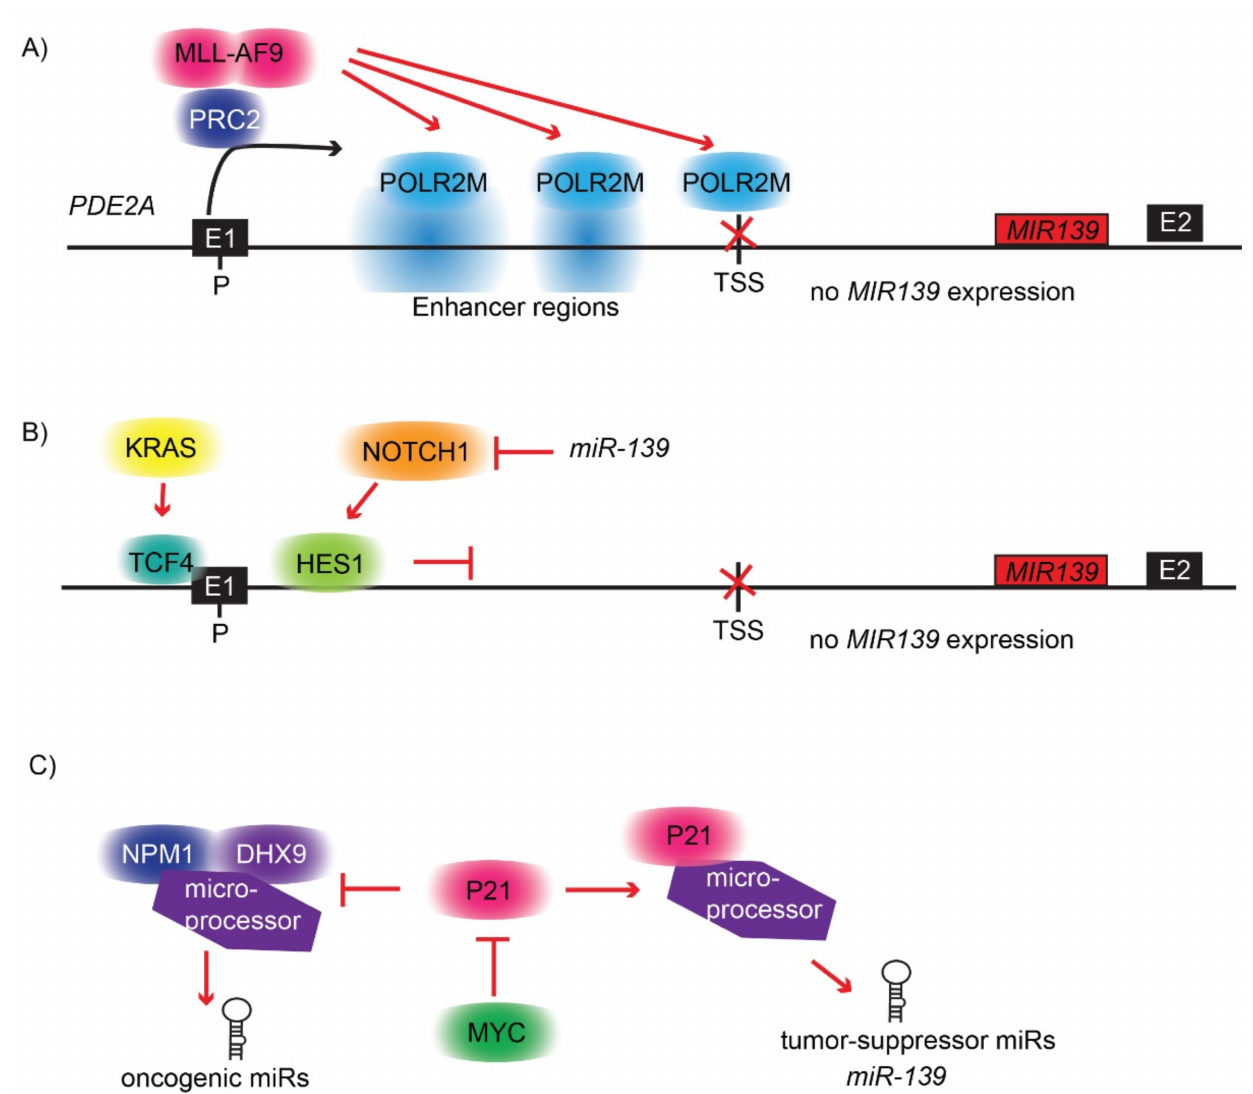
Figure 2. Overview of MIR139 molecular silencing mechanisms. ( A ) Model of MIR139 -silencing mechanism in AML. PRC2 is recruited to the promoter region of PDE2A downstream of MLL- AF9. The host gene PDE2A is expressed at normal levels (black arrow). However, under these conditions, POLR2M is recruited to the enhancer regions and to the TSS of MIR139 (red arrows), which results in transcriptional silencing of MIR139 (red cross). ( B ) Additional silencing mechanisms of MIR139 . Mutant KRAS recruits TCF4- β -CATENIN to the TSS of MIR139 , thereby inhibiting transcription. Activated NOTCH1 signaling results in HES1 binding close to the promoter of PDE2A , which causes downregulation of MIR139 expression. NOTCH1 is a validated target of miR-139